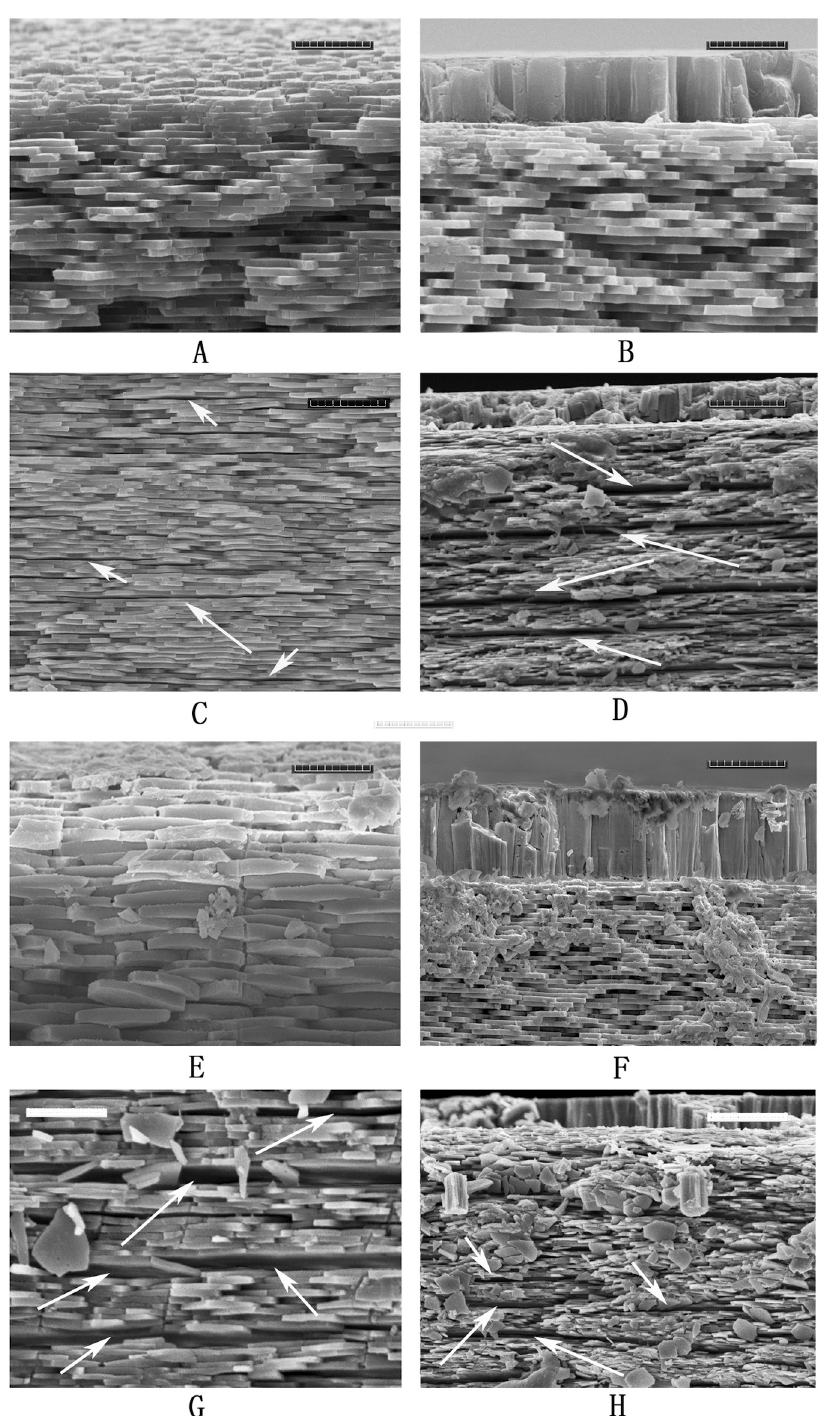
Fig 5. SEM images of shell cross-section at AMS-A and AMS of P . viridis after chitinases digestion. A : the section image of AMS-A from the control sample; B : the section image of AMS from the control sample; C: the SEM image of AMS–A section after chitinase digestion; the etched long cracks at the nacre layer are denoted by arrows; D : the SEM image of AMS section after chitinase digestion; the etched long cracks at the nacre layer are denoted by arrows. E : the section image of AMS-A from the control sample; F : the section image of AMS from the control sample; G : the SEM image of AMS–A section after chitinase digestion; the etched long cracks at the nacre layer are denoted by arrows; H : the SEM image of AMS section after chitinase digestion; the etched long cracks at the nacre layer are denoted by arrows. The bar is 5 μ m for A, B, E, F and G, and 10 μ m for C, D, and H, respectively.